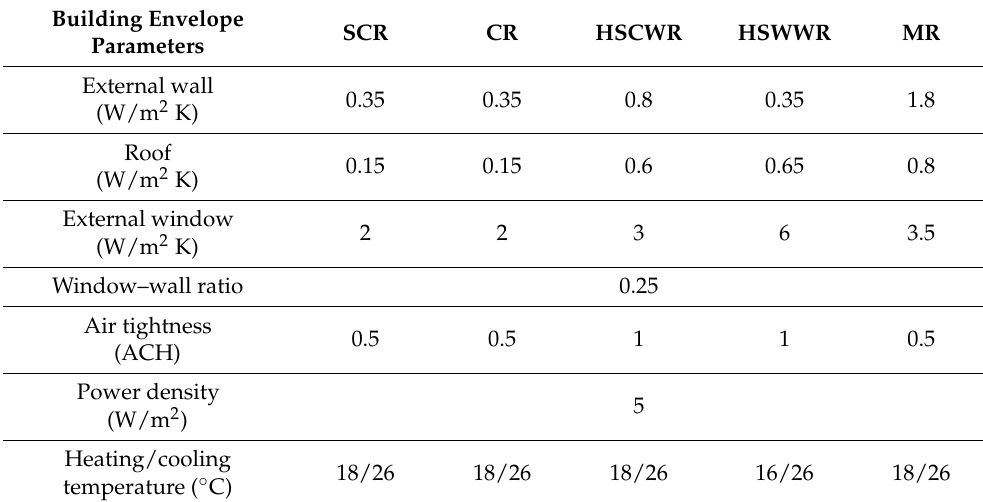
Table 1. Parameters of the building envelope in different building climate